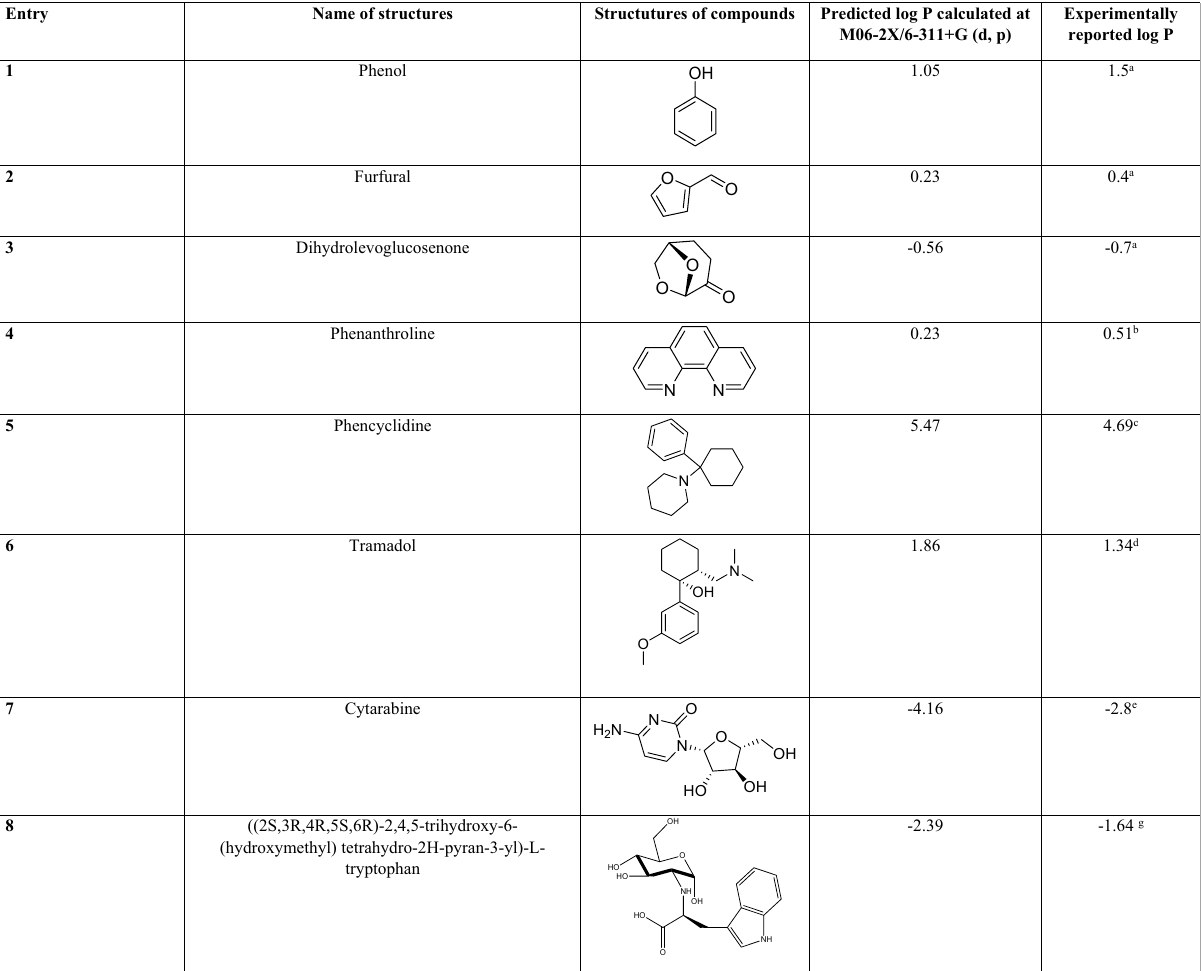
solvents 46 . Figure 5 represents the plot of the experimentally measured log P values versus clog P (calculated log P) for the compounds listed in the entries 1–7 in Table 2 with y = 0.785 − 0.241 and R 2 = 0.98 . Where y and x indicate the experimental and calculated log P values, respectively. This plot predicts the experimental log P value of UNK4 to be − 1.64 and comparing it with the log P value of Cytarabine (− 2.8) 51 suggests that UNK4 tend to have more distribution in the octanol phase than water, which can have positive effects on the penetra- tion of UNK4 through the cell membrane. In contrast, the log P value of Cytarabine indicates that it is a more